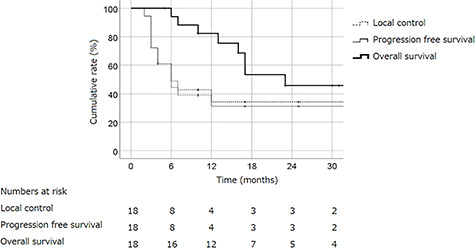
The cumulative LC, PFS and OS rates of the entire cohort (n = 18) are shown. The 2-year LC, PFS and OS rates were 34, 31 and 46%, respectively.